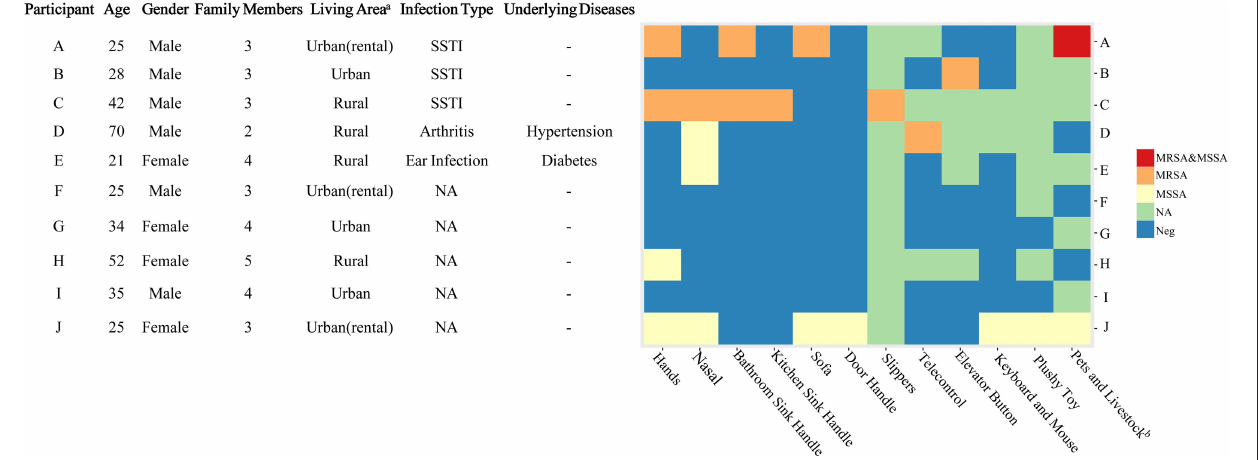
FIGURE 1 | Characteristics of the participants and the methicillin-resistant Staphylococcus aureus isolates in their households. A, B, C, D, and E were the patients with CA-MRSA infection, and F, G, H, I, and J were the healthy subjects. CA, community-acquired; MRSA, methicillin-resistant Staphylococcus aureus ; MSSA, methicillin-susceptible Staphylococcus aureus ; NA, not available; Neg, negative; SSTI, skin and soft tissue infection. a Urban areas are densely populated with populations of ≥ 800,000. b Dogs, cats, and chickens were